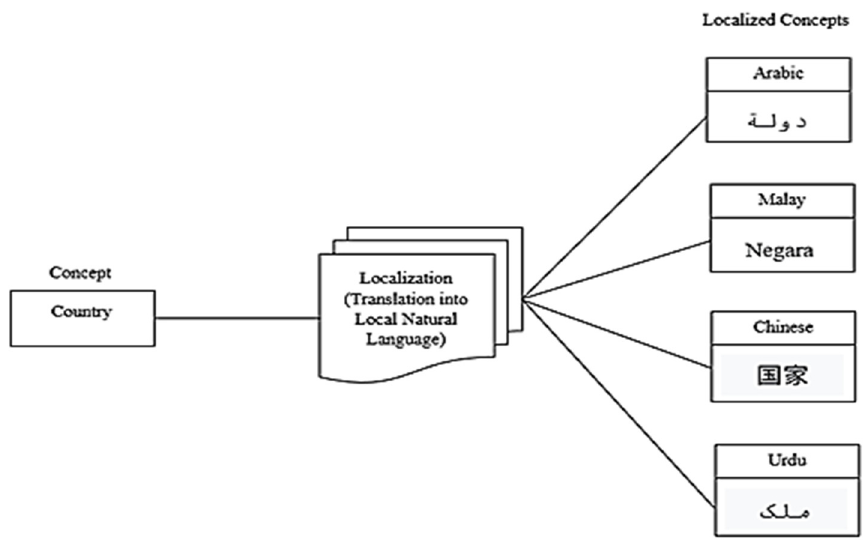
Figure 4. Translation of a concept into local natural languages.